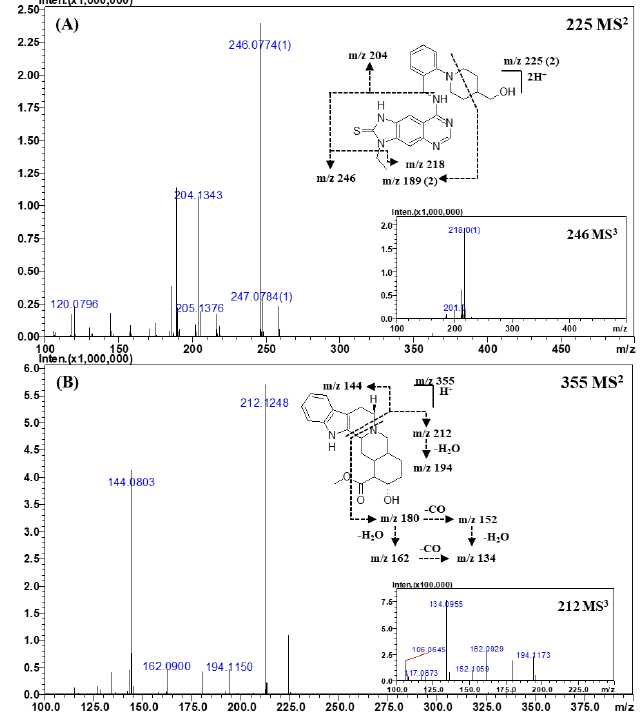
Figure 5. Representative MS n ( n = 2, 3) spectra and proposed fragmentation mechanisms of thioquinapiperifil ( A ) and yohimbine ( B ). The bracketed numbers next to the m / z values indicate the charge state of the ions.